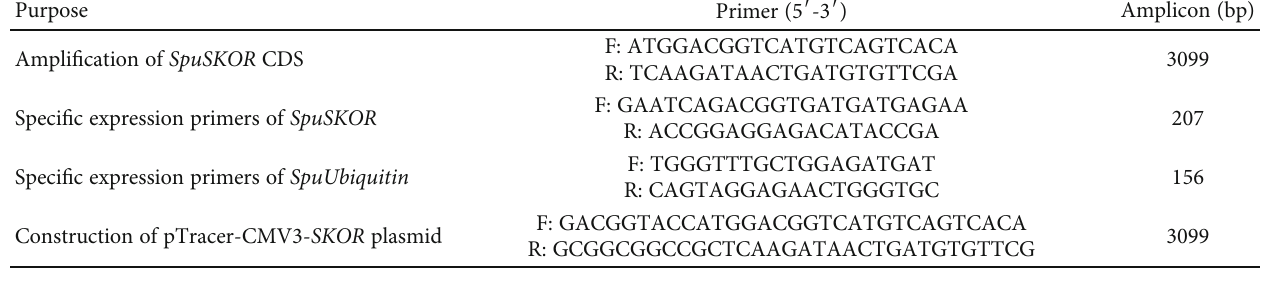
Table 1: Primer sequences used in this work.